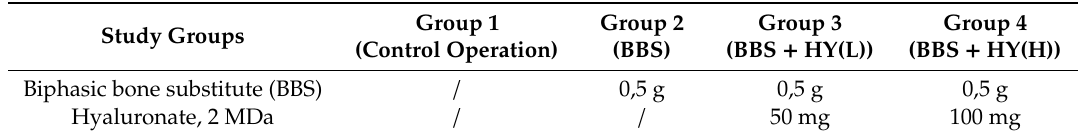
Table 1. The di ff erent study groups and mixing